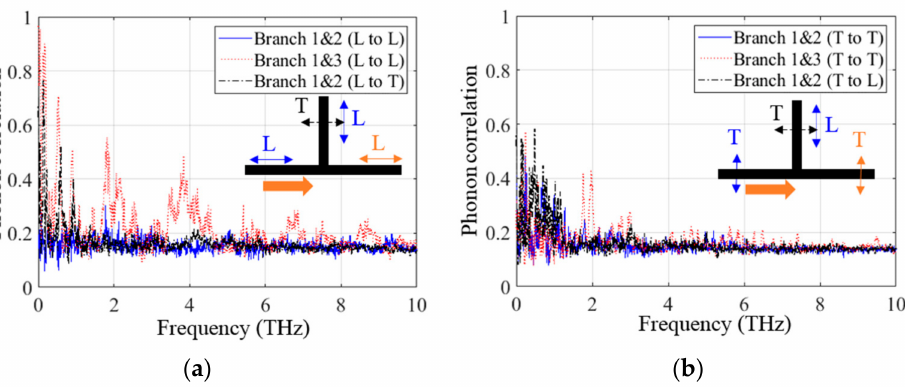
Figure 12. Collective power spectra of the velocity cross-correlation of ( a ) longitudinal and ( b ) transverse vibrations of branch 1 with those of branches 2 and 3 for T-junction